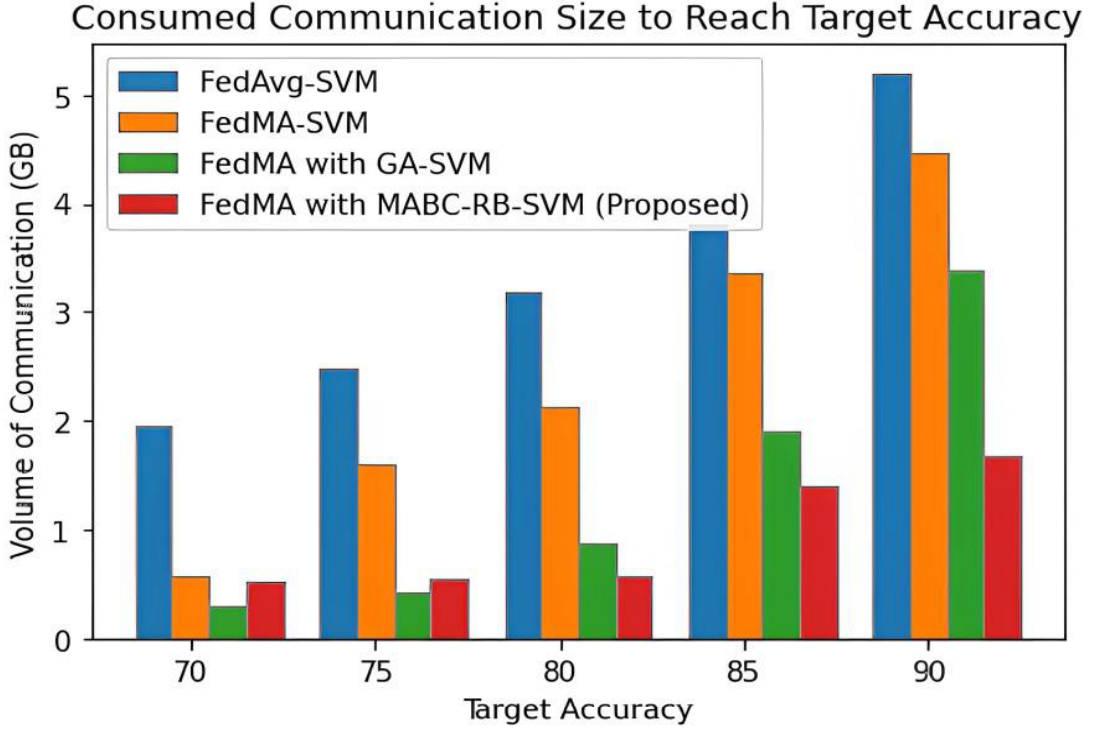
Figure 6. Comparison of consumed communication volume to reach target prediction accuracies.